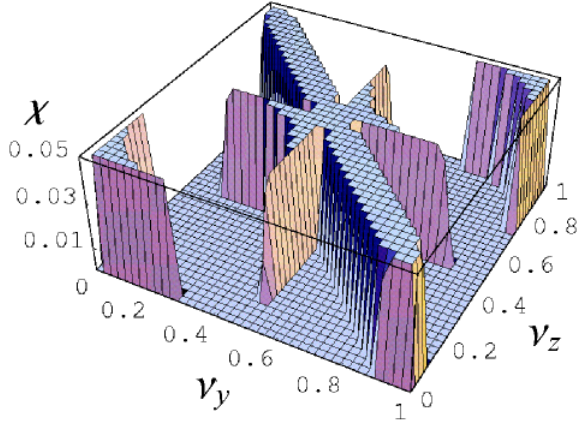
FIG. 3. (Color) The unstable region in the (cid:1) n x , n y (cid:2) plane, for F (cid:1) 0.04 p , b x (cid:1) 0.33 m, b y (cid:1) 0.01 m. The vertical axis is x (cid:8) (cid:1) growth rate 2 1 (cid:2) .